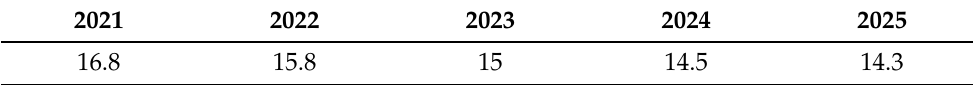
Table 3. Expected unemployment rates for the period